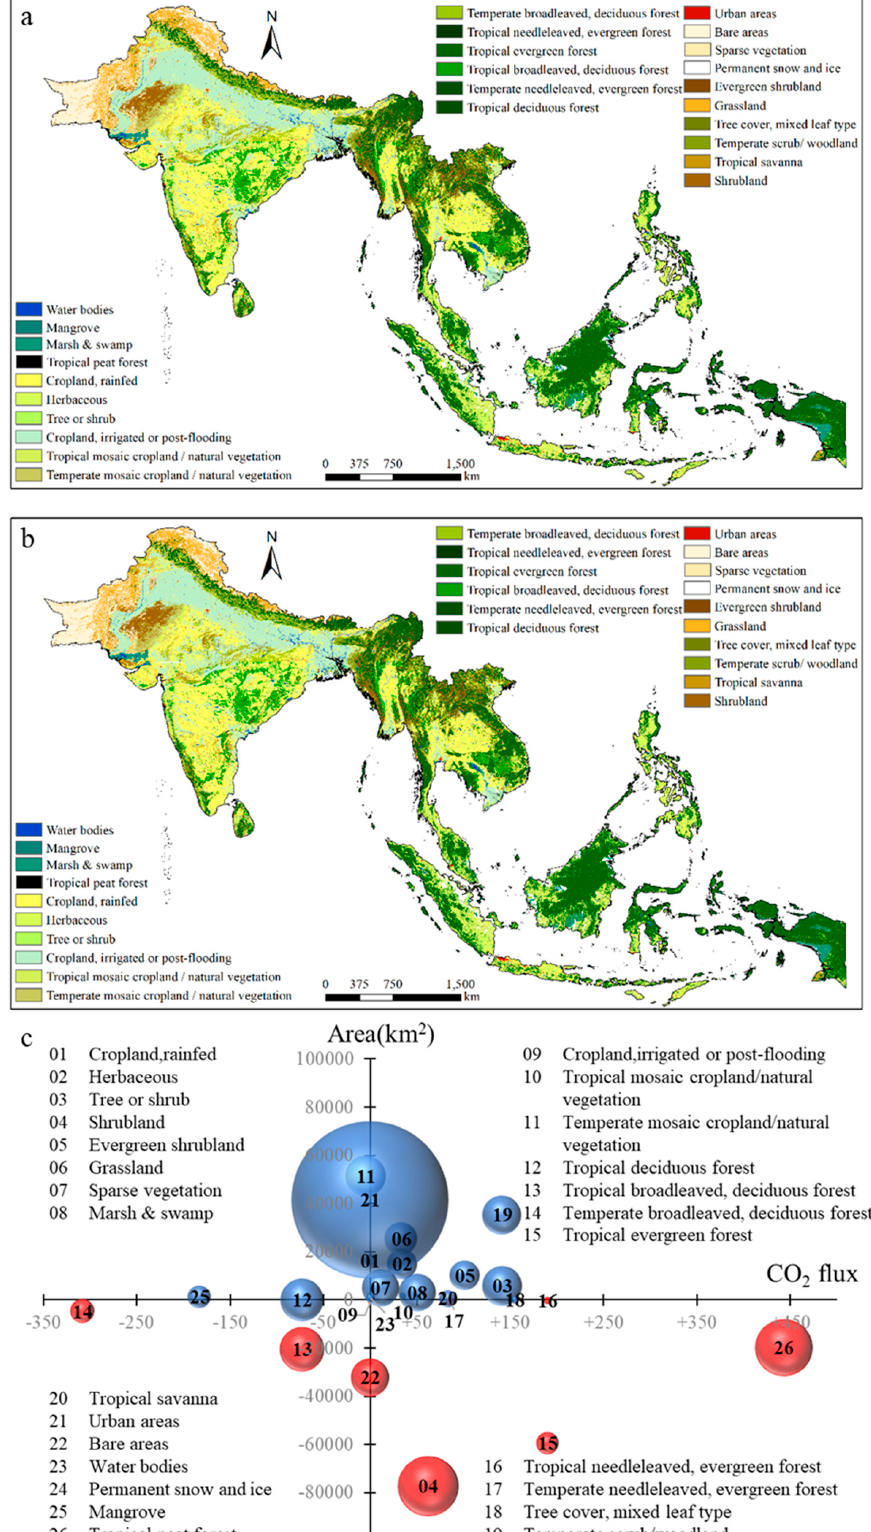
Figure 2. Land cover category change in study area. Spatial pattern of land cover categories in 1992 ( a ) and 2005 ( b ), and ( c ) temporal change of various land cover categories between 1992 to 2015. Bold and black numbers are the land cover categories; the size of circles represents magnitude of change, while their color indicates increase (blue) and decrease (red) of various categories.